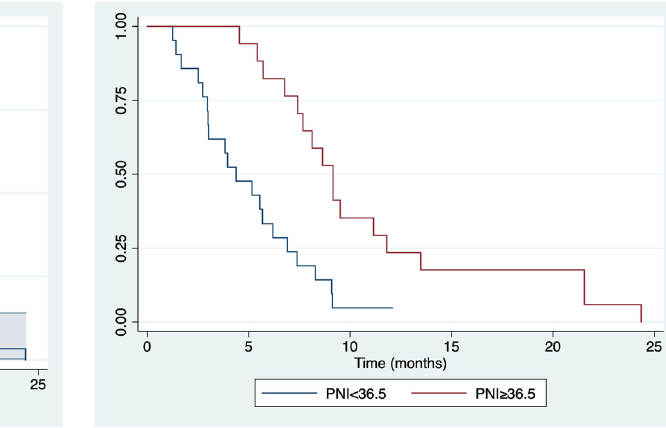
Figure 2: Univariate Kaplan – Meier analysis for